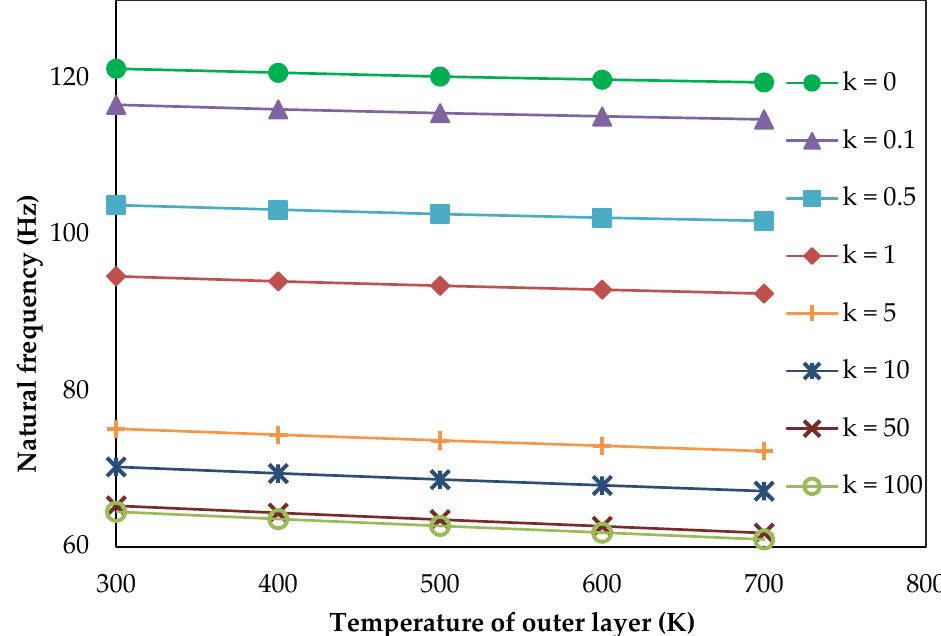
Figure 14. Variation of the natural frequency of a Ti-6Al-4V/aluminum oxide FGM shell under a linear temperature rise for different material composition for re-entry vehicle nose structures.